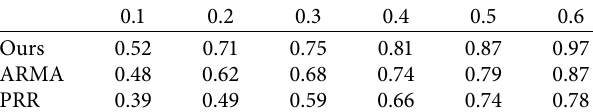
Table 3: Energy consumption.